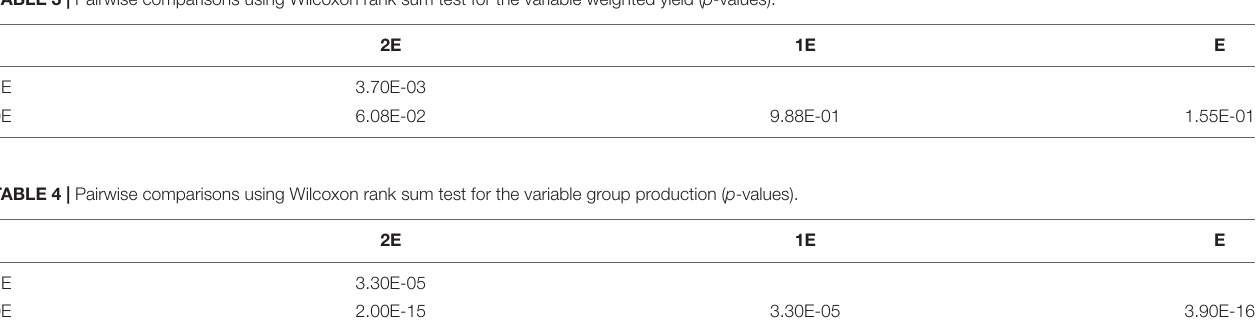
TABLE 3 | Pairwise comparisons using Wilcoxon rank sum test for the variable weighted yield ( p -values).